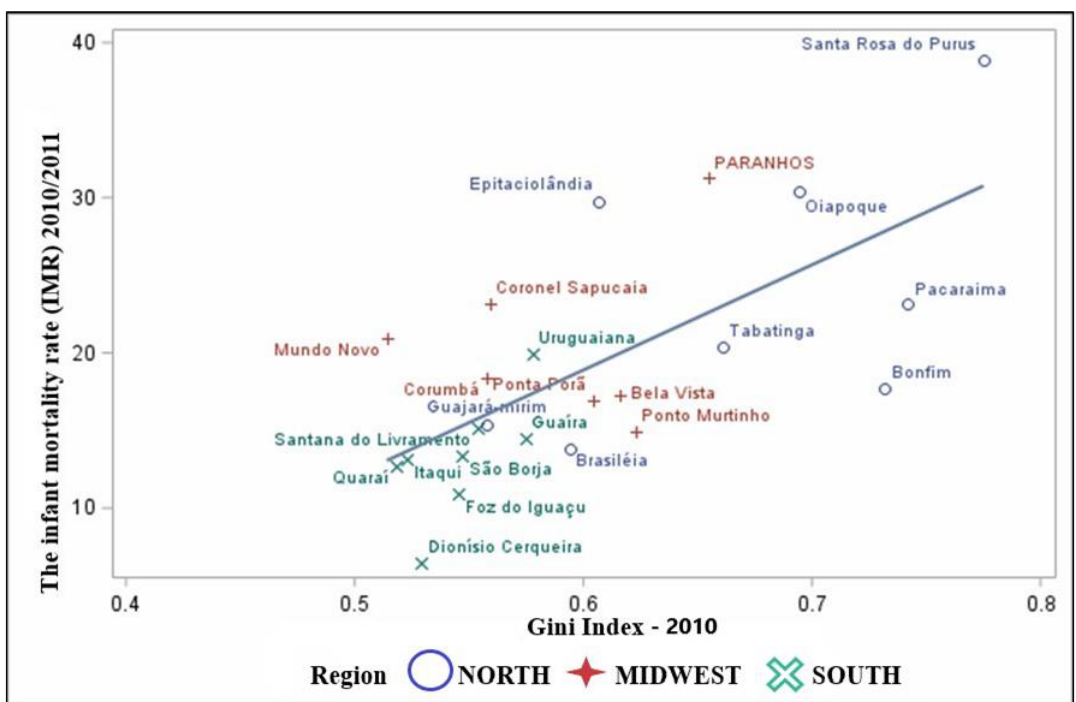
Figure 4. Scatter plot between the averages of IMRs proportional to the Gini Index of the Twin Cities. The HDI-M showed a negative correlation with the IMR (r= − 0.70) and a statistically significant one ( p -value < 0.001) (Figure 5). It is noteworthy that the higher the HDI-M, the lower the average of IMRs in the region, showing an inverse relationship between devel- opment and infant deaths. It is observed that cities in the North and Center-West regions have worse outcomes, such as the cities of Santa Rosa do Purus with Low Development with an HDI-M 0.517 and an average IMR of 38.91 deaths/1000 LB. In sequence, the Twin City Paranhos — MS with 31.26 deaths/1000 LB and the HDI-M 0.588, with low develop- ment.